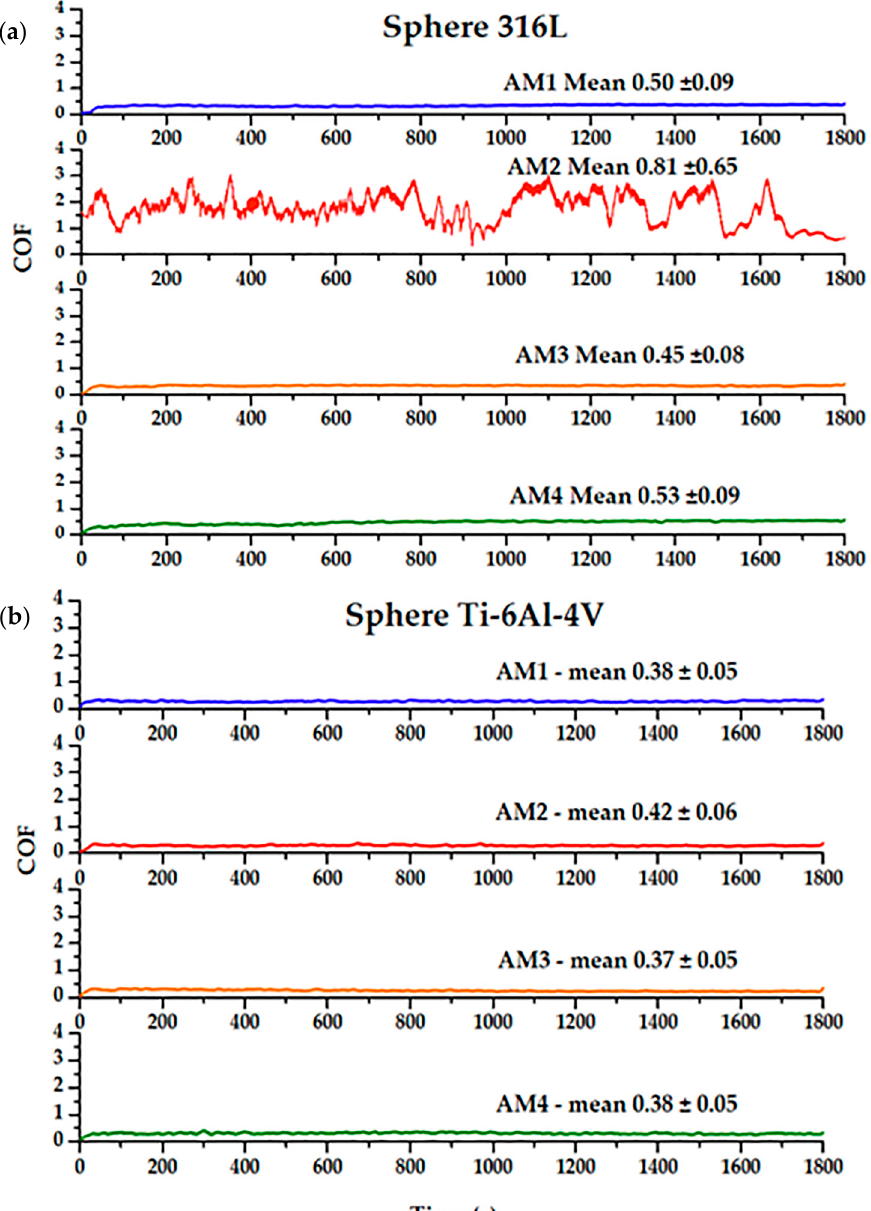
Figure 9. Friction coefficients variation from the Co-Cr-Mo alloy samples (AM1-AM4), and counter- body ( a ) a 316L steel sphere and ( b ) a Ti-6Al-4V sphere.